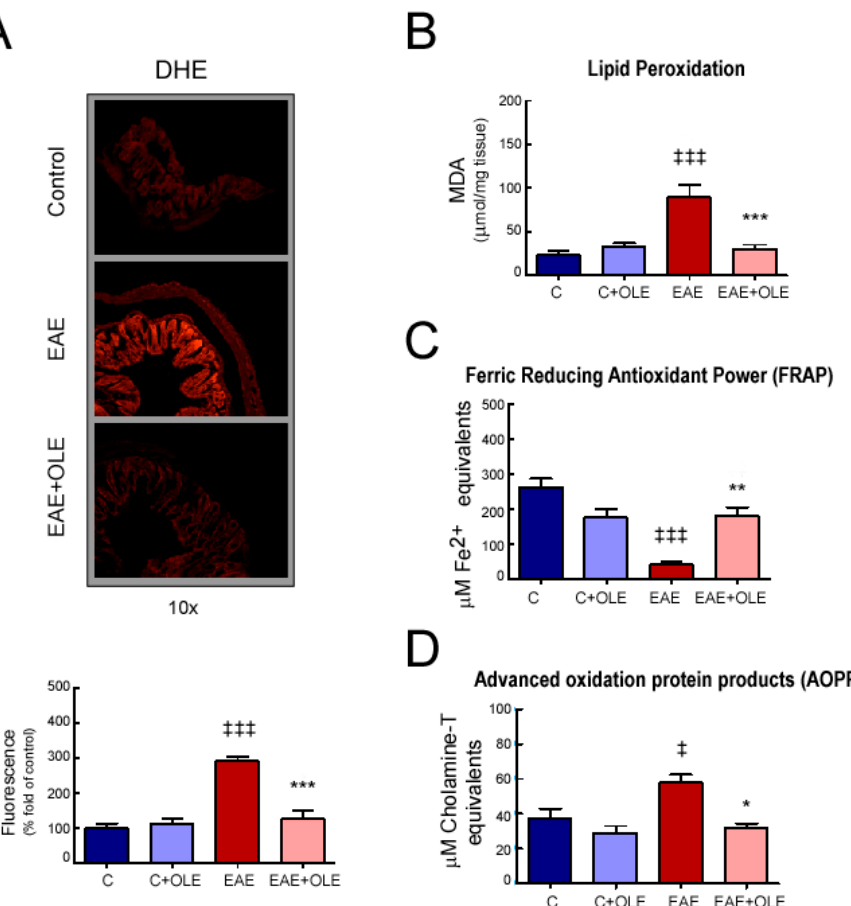
Figure 5. OLE treatment reduces oxidative stress in colon tissue from EAE mice. ( A ) Representative photomicrographs of colon tissue stained with DHE. Histological analysis by fluorescence microscopy and quantification. Objective lens 10 × . Expression levels of malondialdehyde, MDA ( B ); advanced oxidized protein products, AOPP ( C ); and ferric reducing/antioxidant power, FRAP ( D ) in colon tissue. Results were expressed as the mean ± SEM, n = 4–7 per group. ‡ p < 0.05 and ‡‡‡ p < 0.001 vs. control; and * p < 0.05, ** p < 0.01 and *** p < 0.001 vs. untreated-EAE. C, healthy mice. C + OLE, healthy mice treated with OLE. EAE, induced mice. EAE + OLE, induced mice treated with OLE.